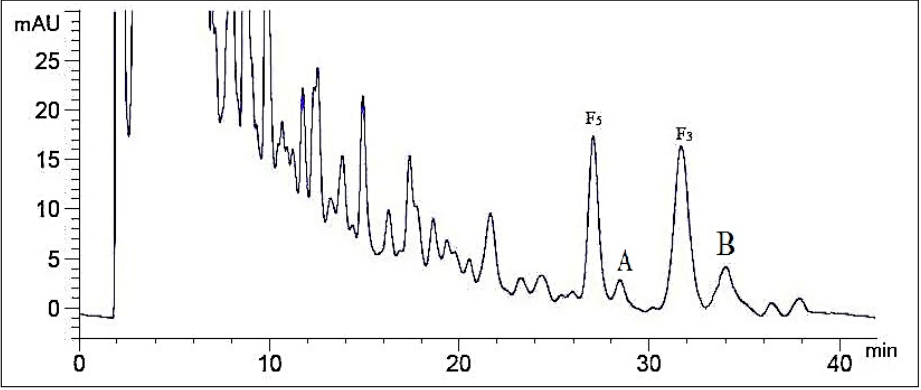
Figure 2. The chromatogram of CEFBPG (acetonitrile:water:phosphoric acid = 28:71:1).